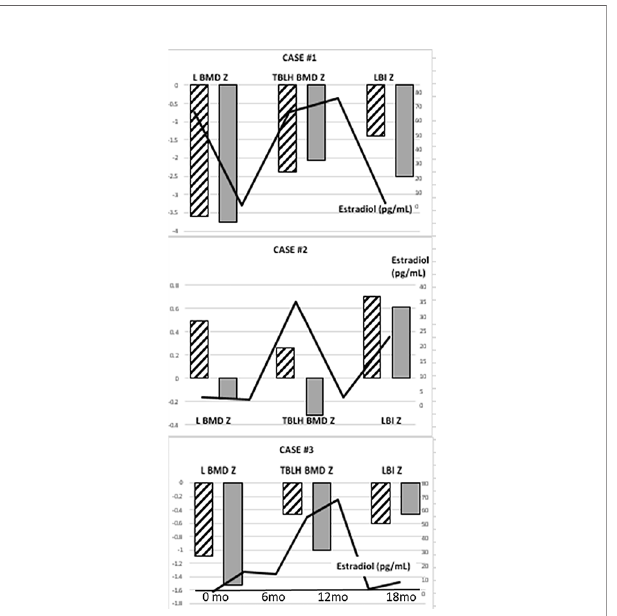
FIGURE 1 | Lumbar (L) and Total Body Less Head (TBLH) BMD Z-scores and LMI-Z in three adolescents with CAIS, history of early gonadectomy, and longitudinal DXA measurements. Hatched columns represent the results of the initial DXA study and gray columns represent the follow-up DXA results. Estradiol levels throughout the time of follow-up are shown as a solid